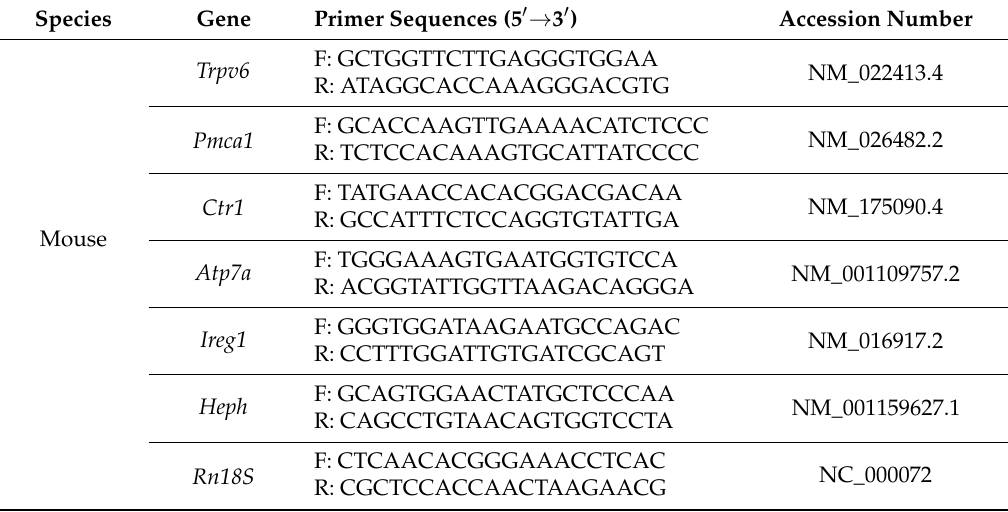
Table 1. Oligonucleotide sequences for quantitative real-time